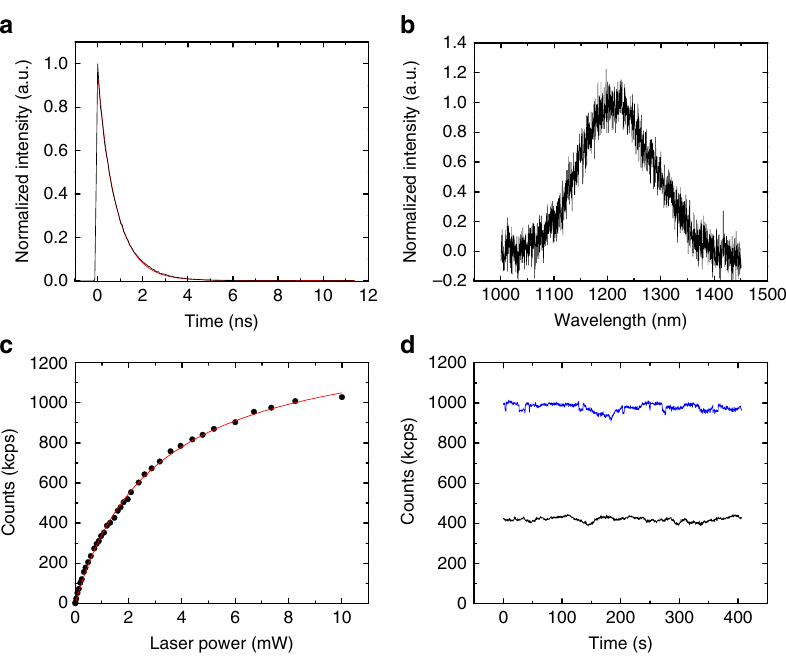
Fig. 2 Single-photon emitter characterization. a Lifetime measurement. The black curve is the raw data fi tted with a single-exponential equation I ( t )exp( − t / τ ). From the fi tting, τ = 0.81 ± 0.01 ns. b RT PL spectrum of the SPE 4. c Saturation behavior of the SPE 4 at different laser powers. The black curve is the raw data fi tted with I ( P ) = I s /(1 + P 0 / P ). d Fluorescence intensity trace at laser powers 1.5 mW (black) and 8.2 mW (blue) with a sampling time of 100